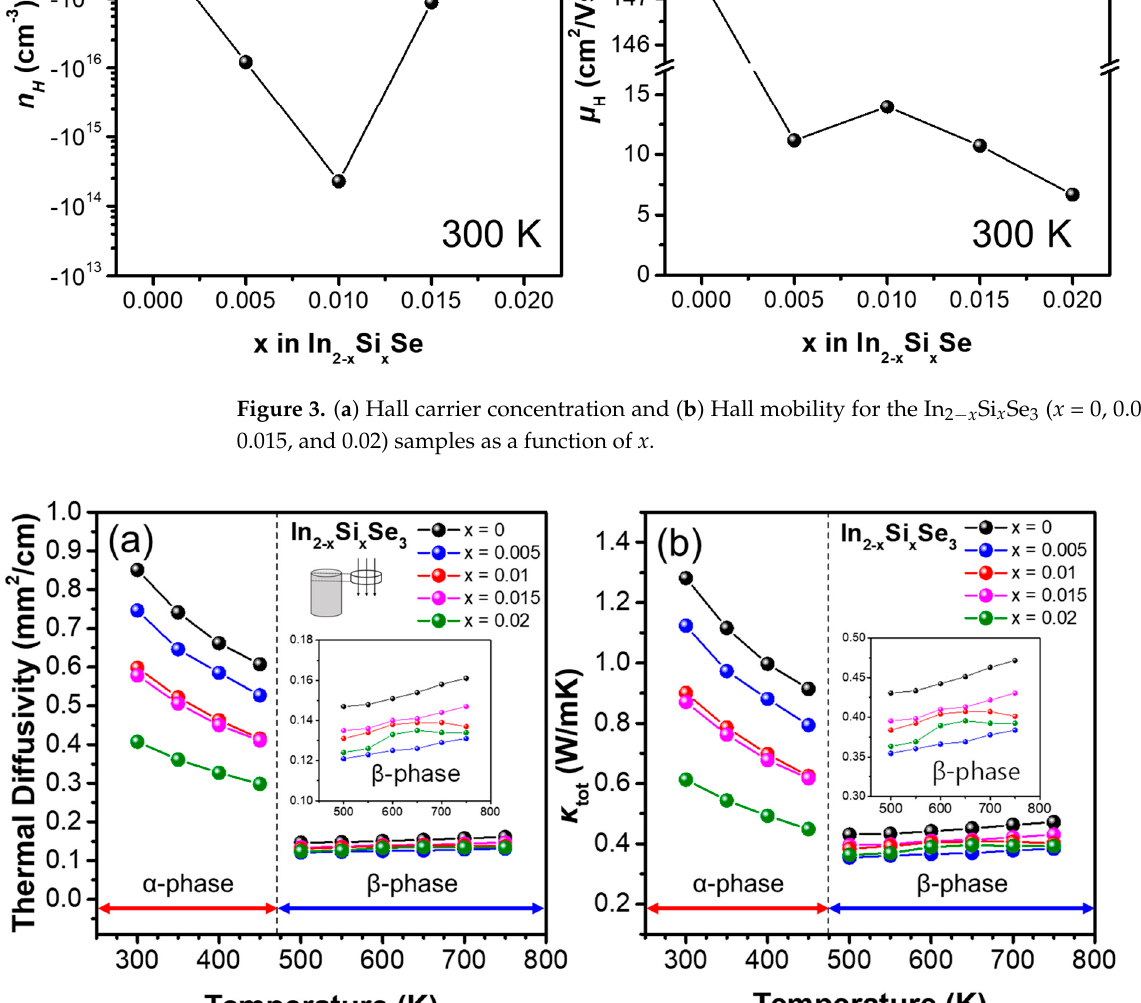
Figure 3. ( a ) Hall carrier concentration and ( b ) Hall mobility for the In 2 − x Si x Se 3 ( x = 0, 0.005, 0.01, 0.015, and 0.02) samples as a function of x .